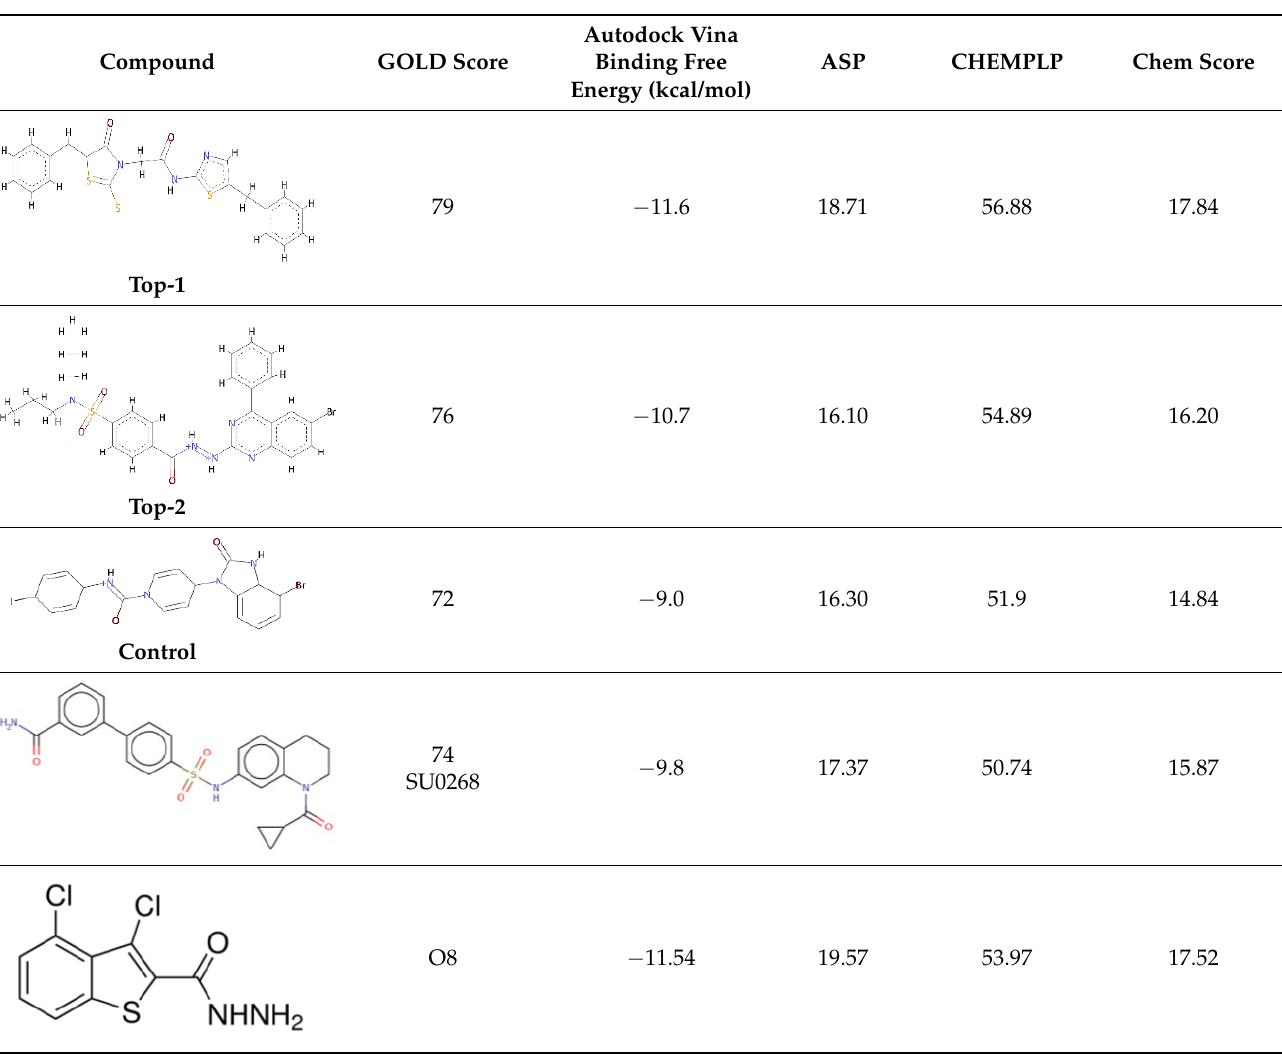
Table 1. Virtually screened compounds and their docking scores.